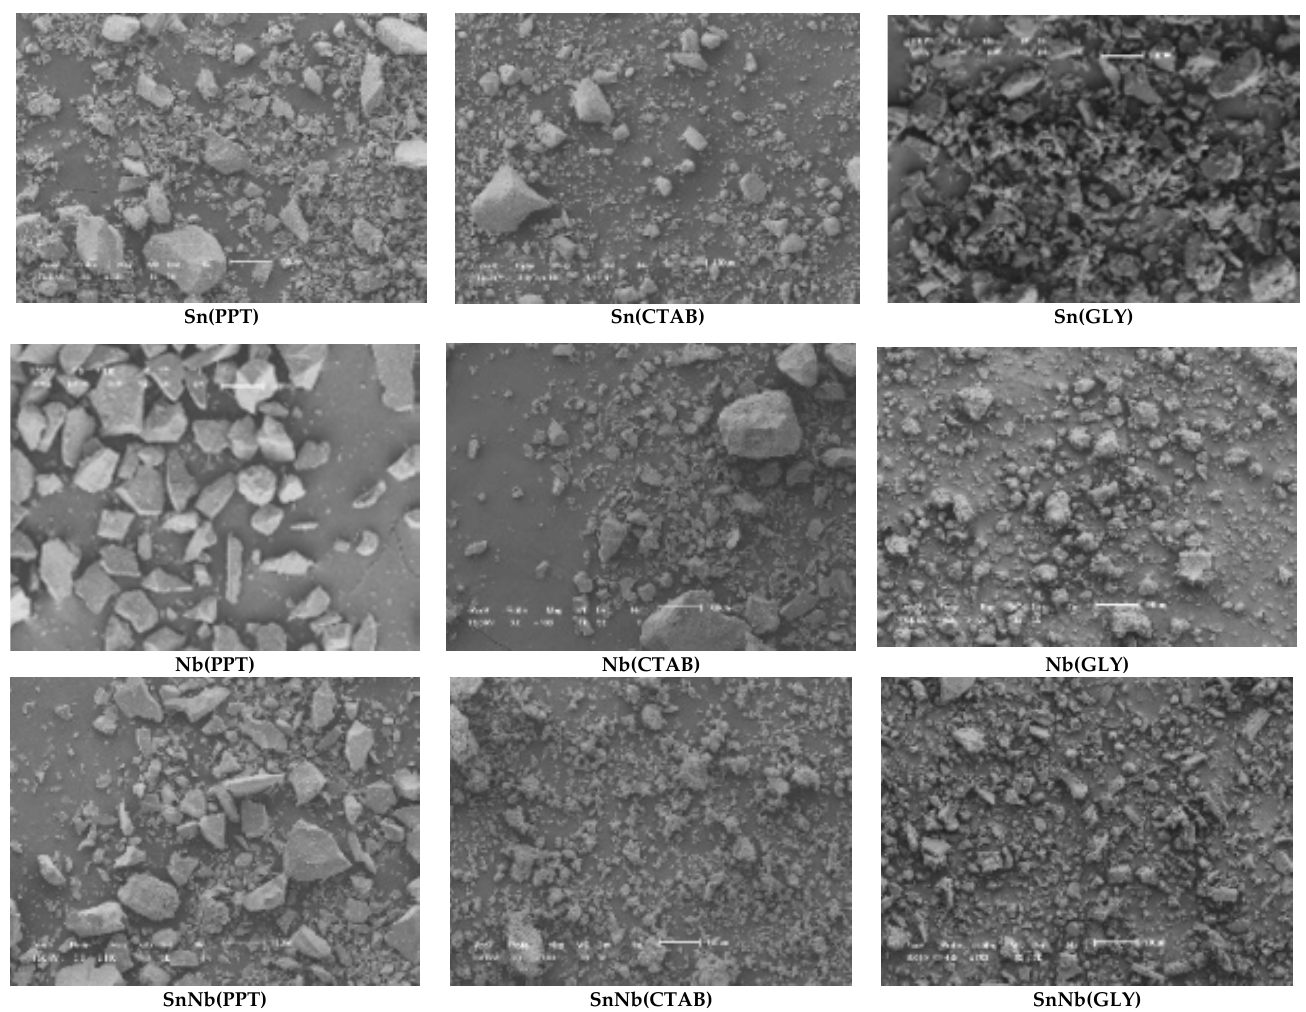
Figure 7. Scanning-electron-microscopy (SEM) images of the catalysts. The scale bar of all images is 100 μ m (see Figures S3, S4 and S5, Supplementary Information).